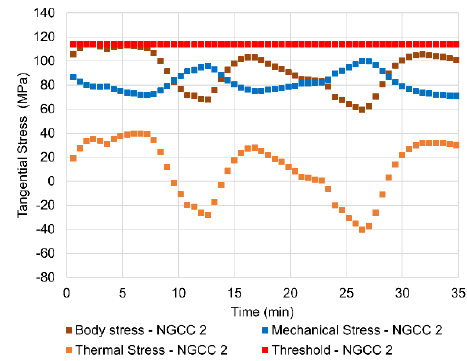
Figure 22. Mechanical and thermal stresses for NGCC 2: Case 5.